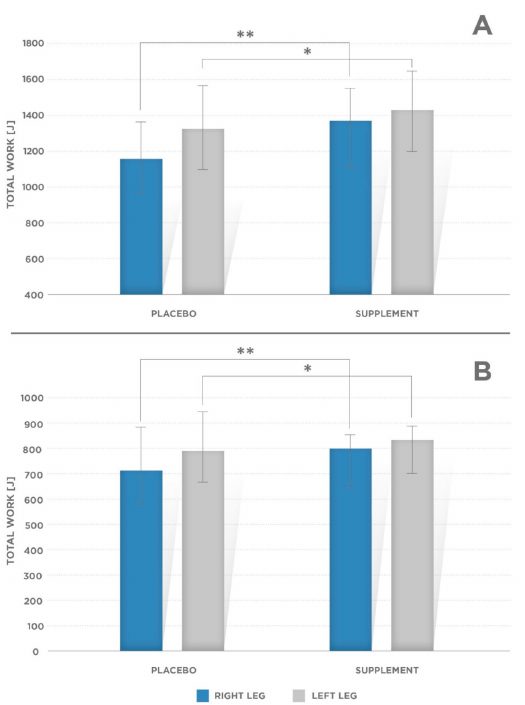
Figure 3. Mean values of total work (Twork) at 60 ◦ / s for ( A ) the right and left knee extensors. Significant di ff erence was observed for the right leg (** p = 0.001) and left leg (* p = 0.002), and ( B ) for the right and left knee flexors. Significant di ff erence was observed for the right leg (** p = 0.001) and left leg (* p = 0.002). Error bars indicate standard deviation (SD).